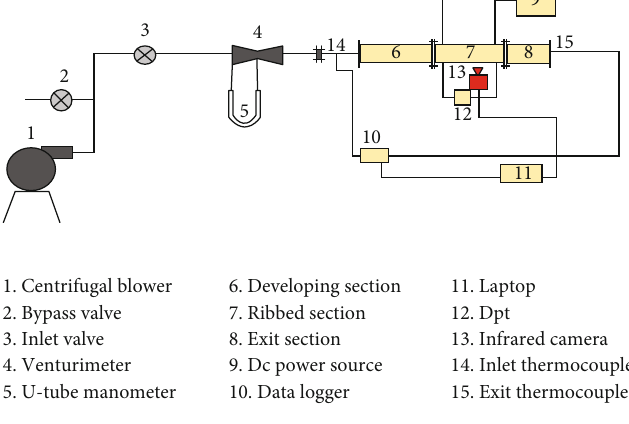
Figure 1: Illustration of experimental setup.